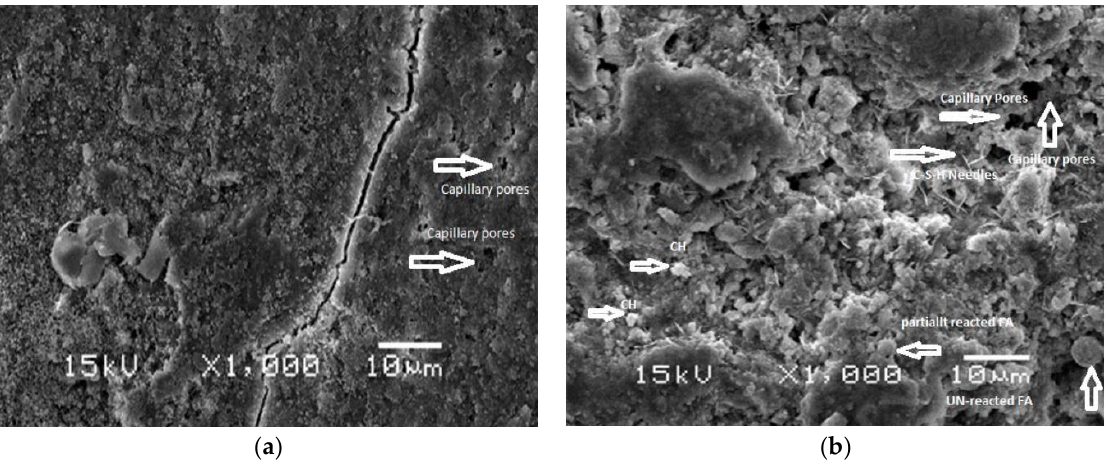
Figure 7. Microstructure of samples: ( a ) Without fly ash; ( b ) With 30% fly ash [147]